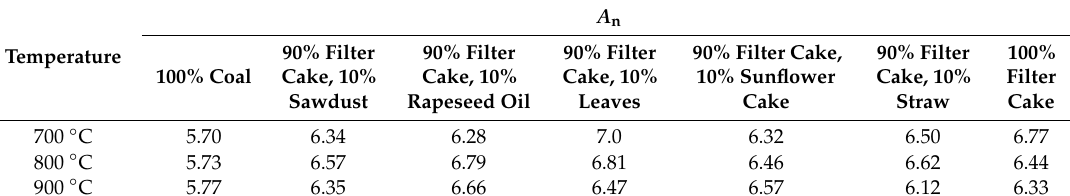
Table 6. Resulting e ffi ciency indicators calculated according WSM.